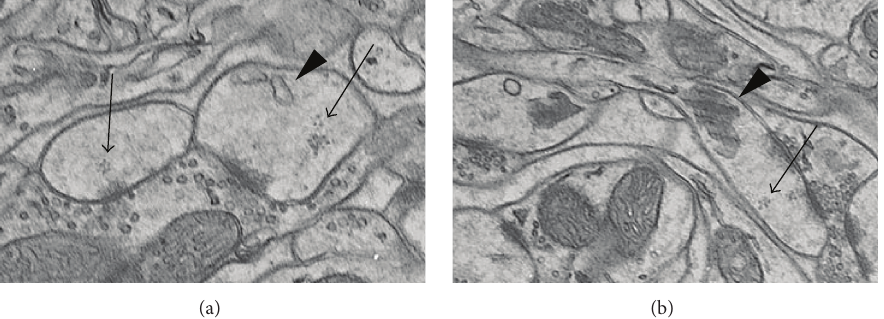
Figure 5: Electron micrographs showing polyribosomes in sER-free, sER-containing (a), and SA-containing (b) spines. Arrows: polyribosomes; arrowhead: sER (a) and spine apparatus